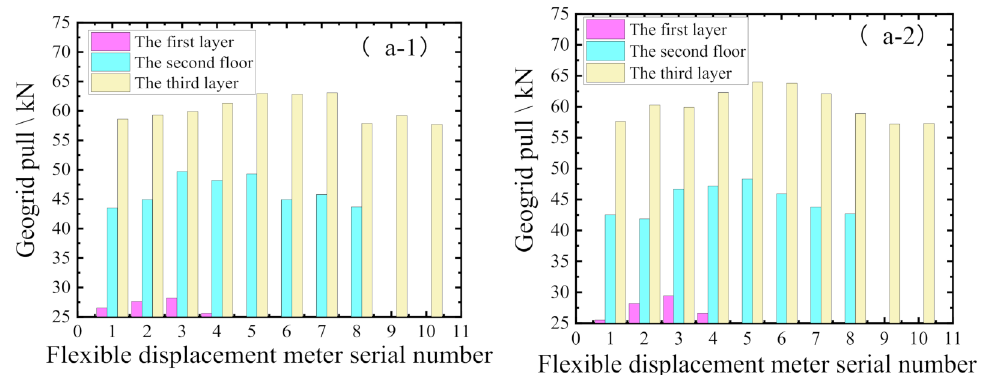
Figure 9. Geogrid pull curve: ( a-1 ) the first set of geogrid tension curves; ( a-2 ) the second geogrid tension